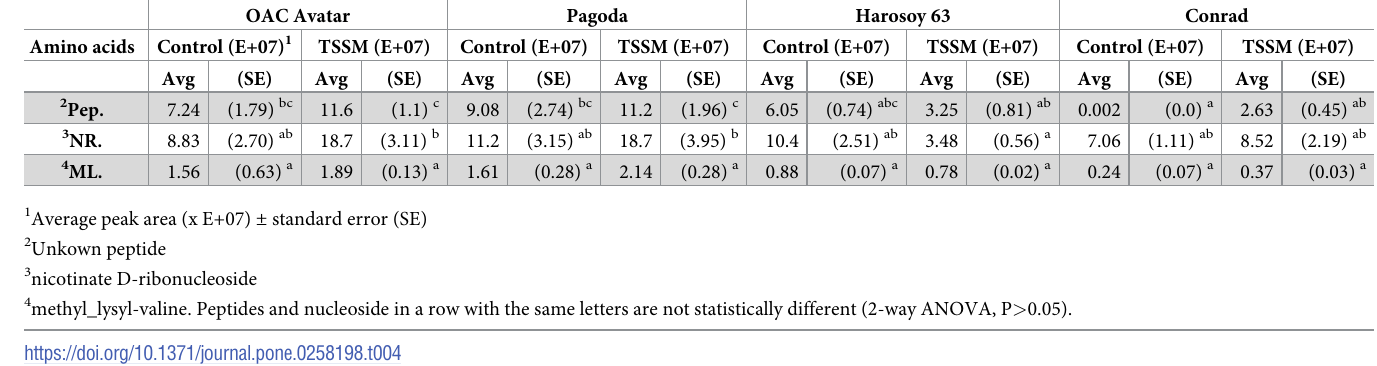
Table 4. The effect of two-spotted spider mite feeding on peptides and nucleosides in leaves of 2 resistant and 2 susceptible soybean cultivars after 4 weeks. Resistant/tolerant